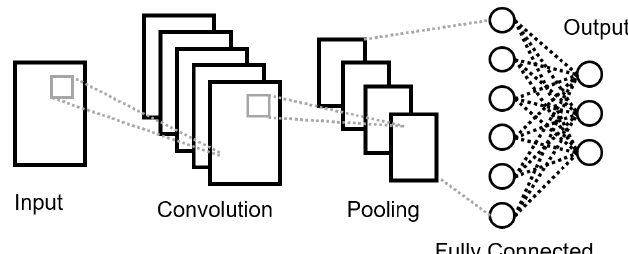
Figure 4. General Structure of an CNN.